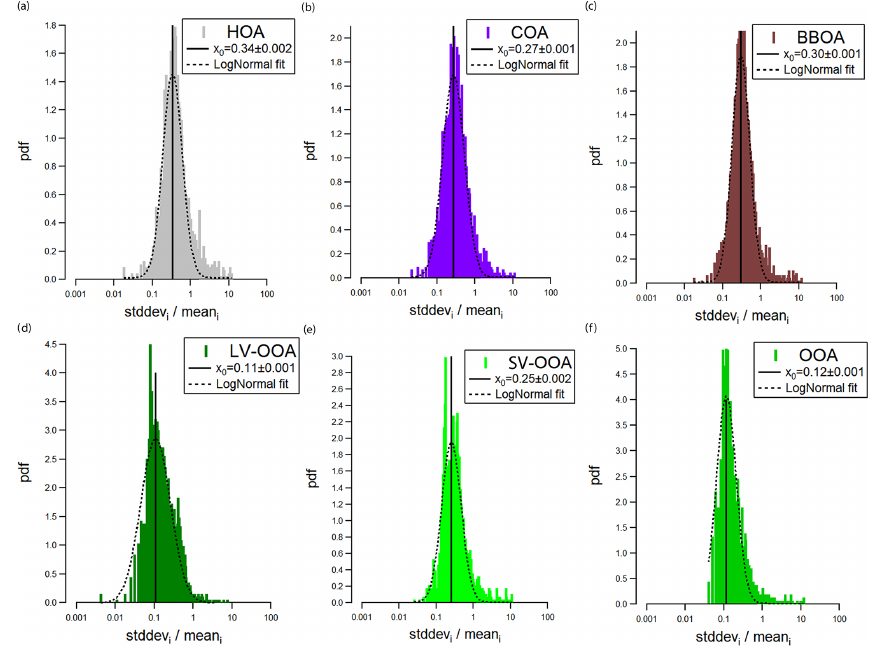
Figure 8. Probability density functions for the PMF error of the six factors as a logarithmic representation on the x